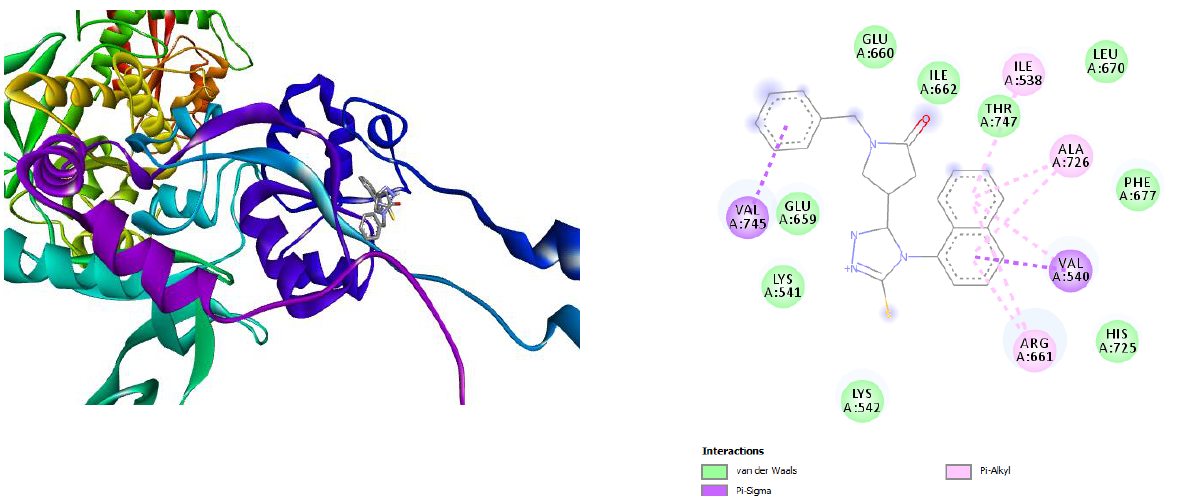
Fig. 3. Superposition of molecule 11 and diagram of intermolecular interactions in complex with N-methyl-d-aspartate receptor (NMDAR) (PDB ID: